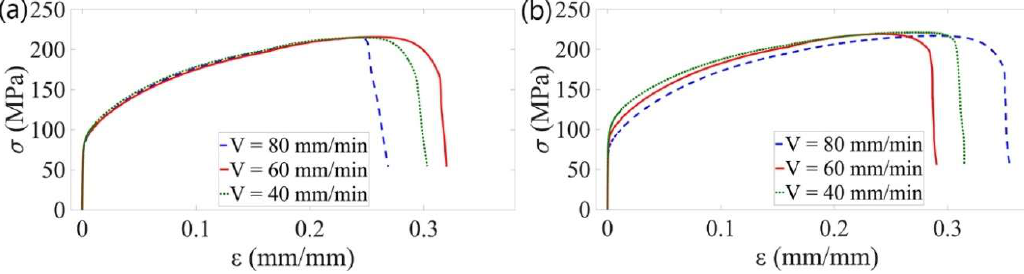
Figure 10. Comparison of the representative tensile curves of the specimens joined by FSW with various traverse speeds: ( a ) orientation L; ( b ) orientation T.